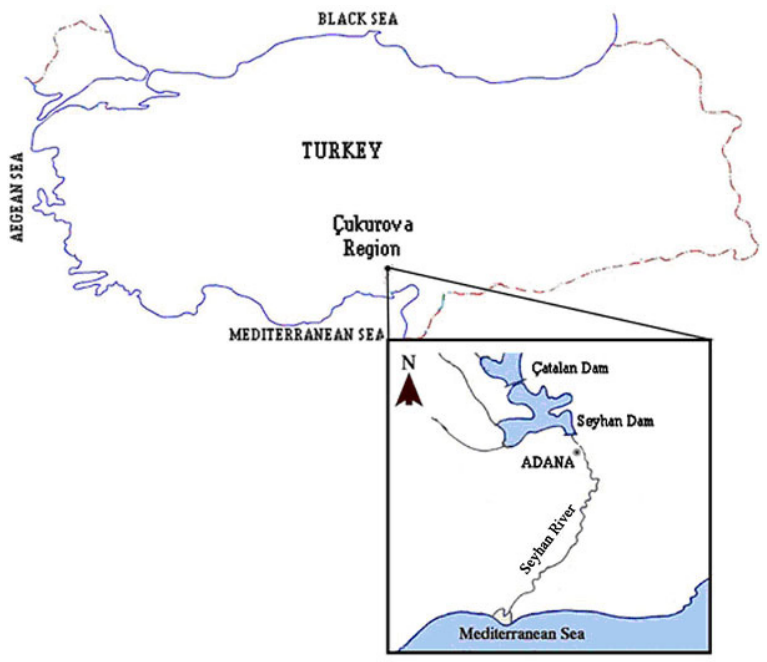
Figure 1. Location of the study site in the Çukurova